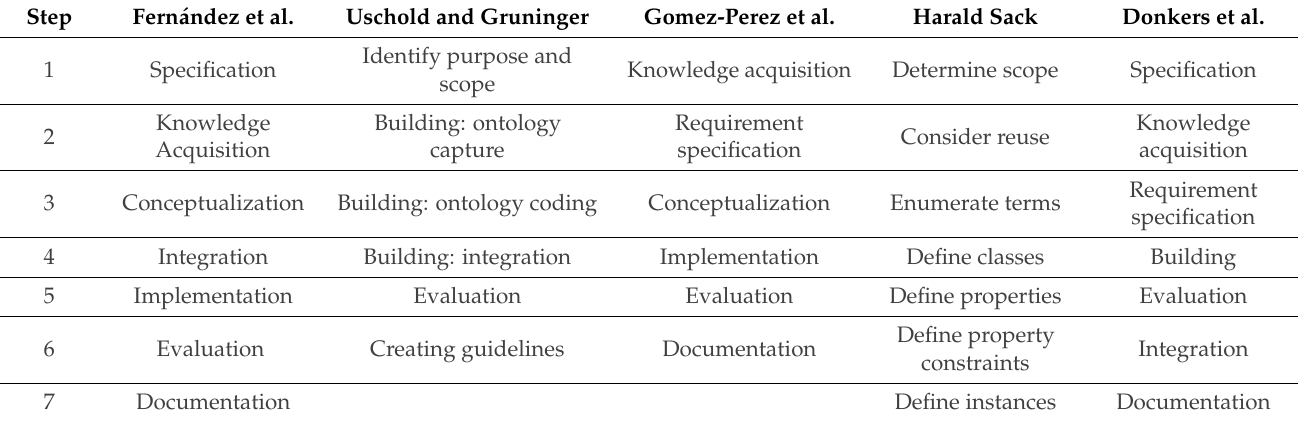
Table 1. Step-by-step ontology development approaches.